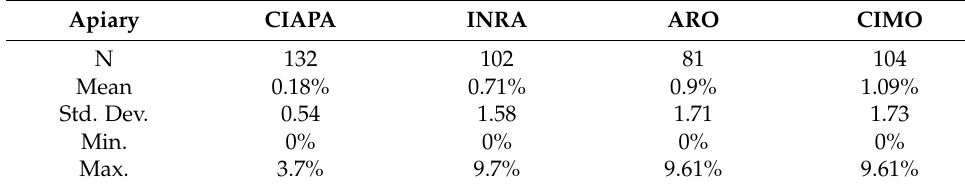
Table 4. Statistics for the percentage of Varroa destructor in 300 honey bees per apiary across sampling rounds ( n = 419). Islands are not included as they were the mite free.